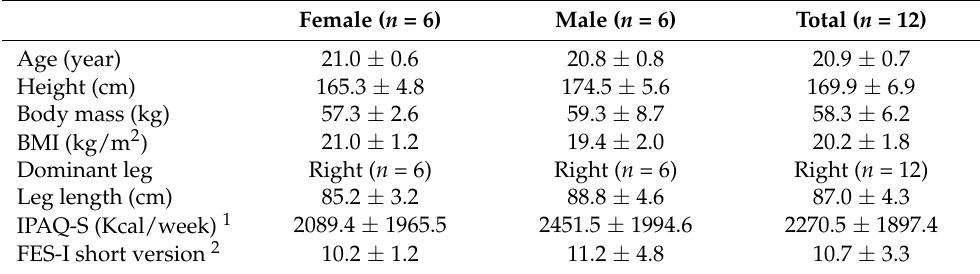
Table 2. Demographic data (mean ± SD) of twelve participants.